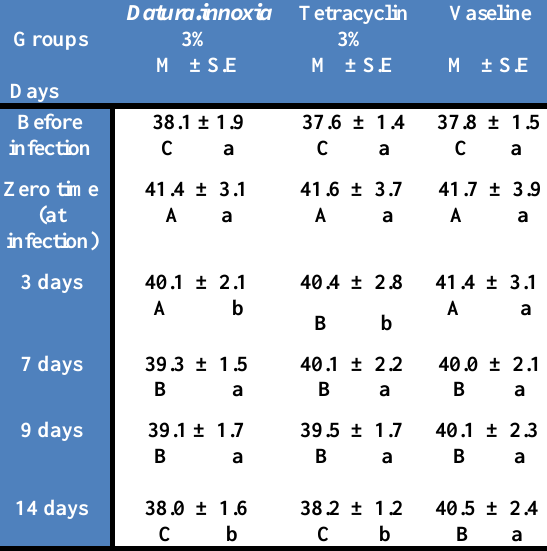
Table, 4: Body temperature ( ᵒС ) of artificilly infected rabbit in different